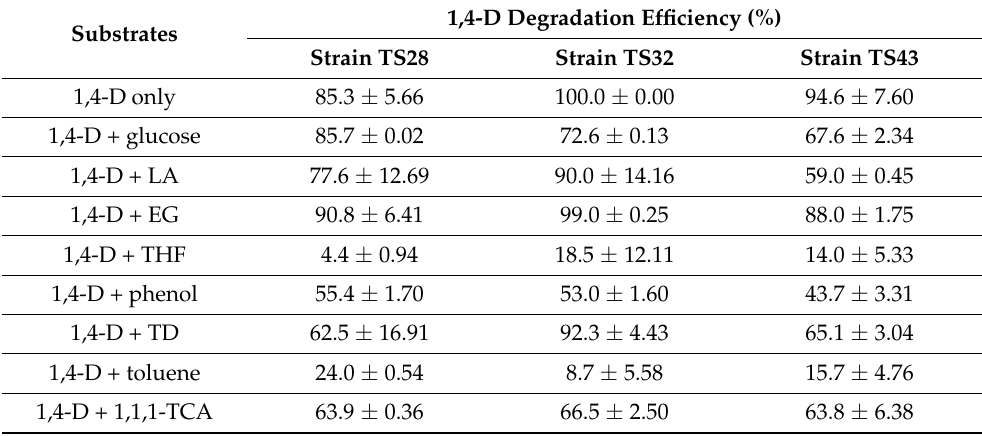
Table 1. 1,4-D degradation efficiency of the isolated strains in the presence of additional carbon sources (100 mg-substrate/L) after 12 days of incubation. 1,4-D Degradation Efficiency Substrates